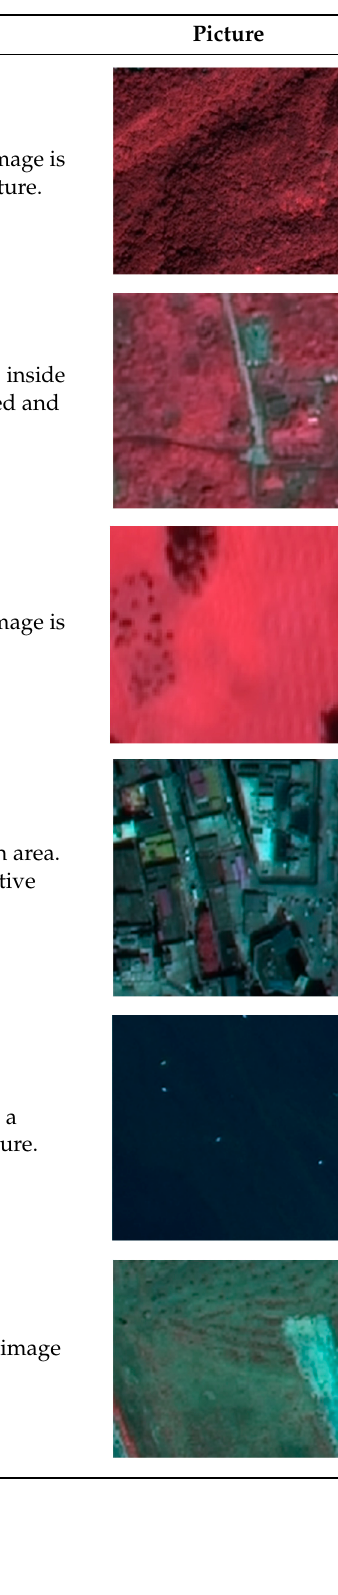
Table 1. Land coverage type determination mark of picture.